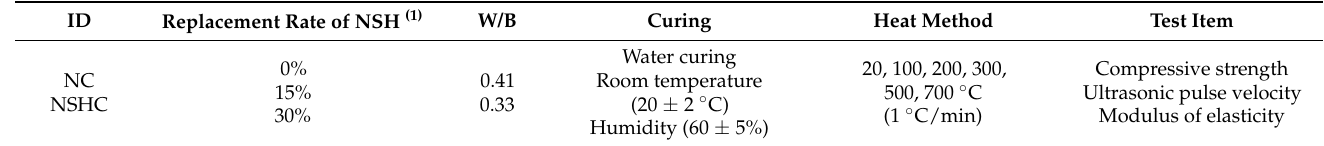
Table 2. Experimental parameters.